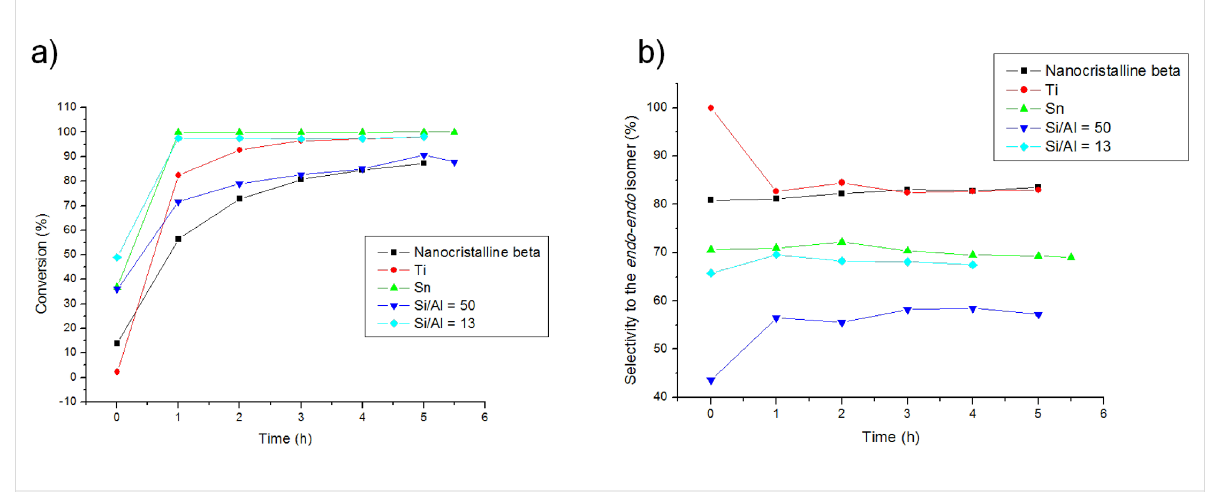
Figure 2: Effect of Lewis and Brønsted acid sites in the conversion (a) and selectivity (b) of the DAR.